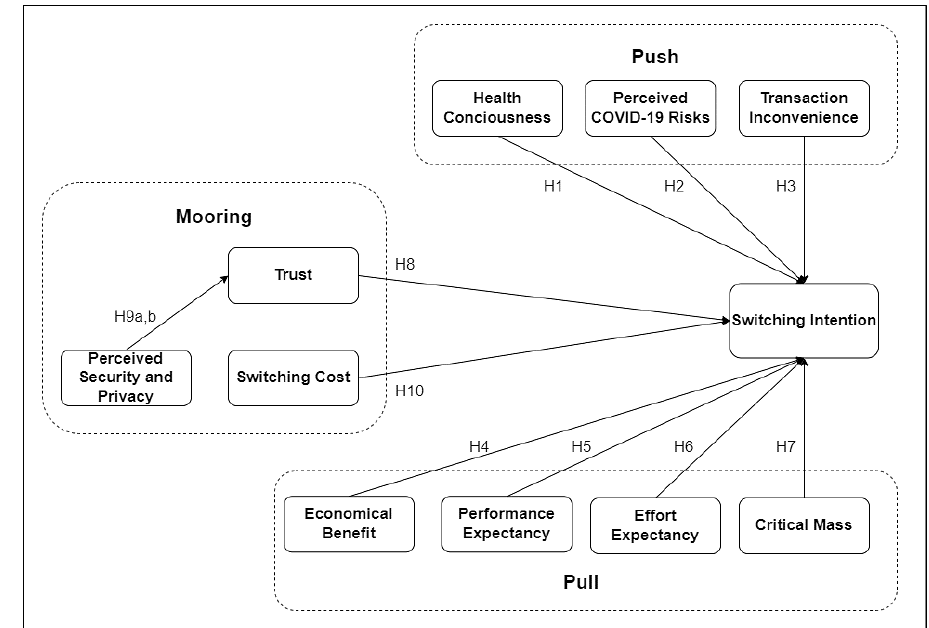
Figure 2. The proposed research